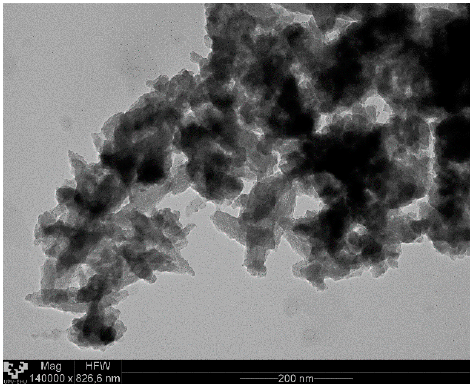
Figure 3. Transmission electron microscopy (TEM) micrographs of FeHA nanoparticles.